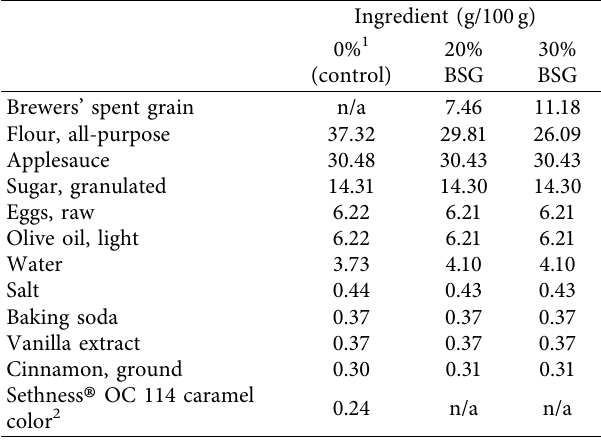
Table 1: Ingredient analysis of control and brewers’ spent grain (BSG) muffin